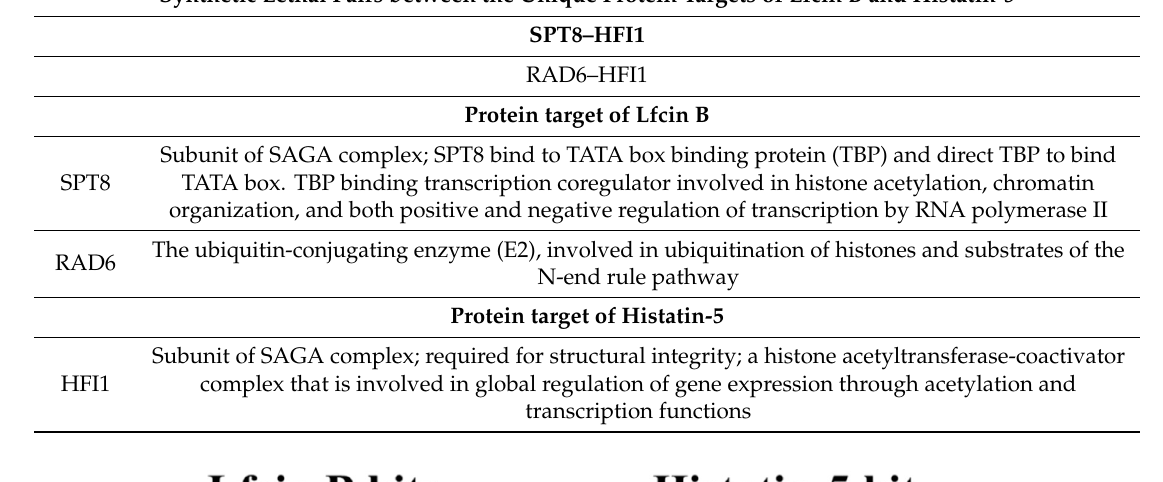
Table 2. Synthetic lethal pairs between the unique hits of Lfcin B and Histatin-5 along with the functions of individual proteins involved in these synthetic lethal pairs.